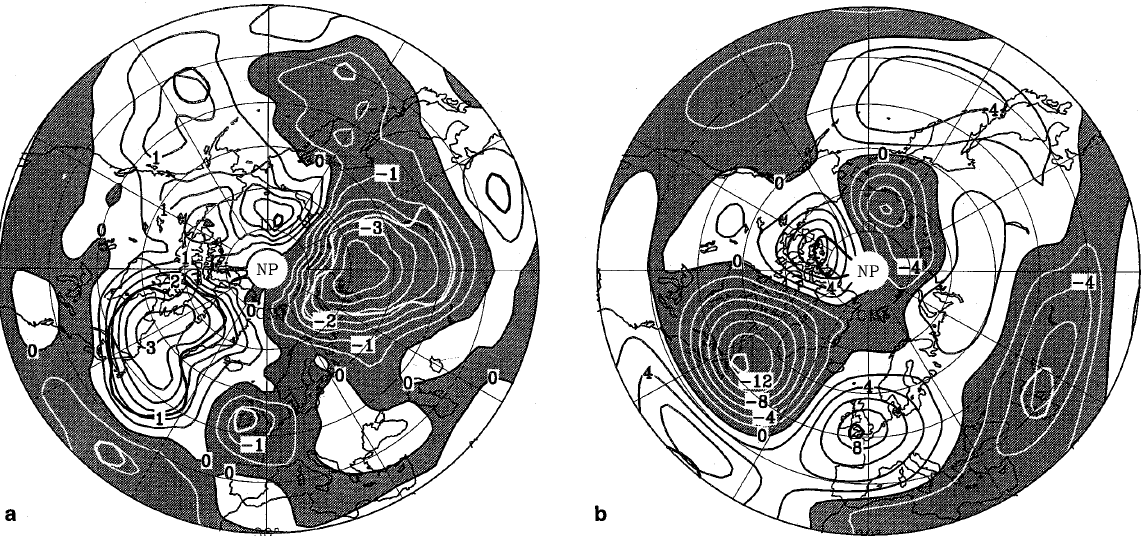
Fig. 5a, b. Decadal change during March in the period 1979–92 of a ozone disturbance by Nimbus TOMS, D dO3*/dt = 0.5 DU/y b geopotential disturbance, D d G */dt = 2 gpm/y. Shaded area : negative. Thick encircled areas are significant